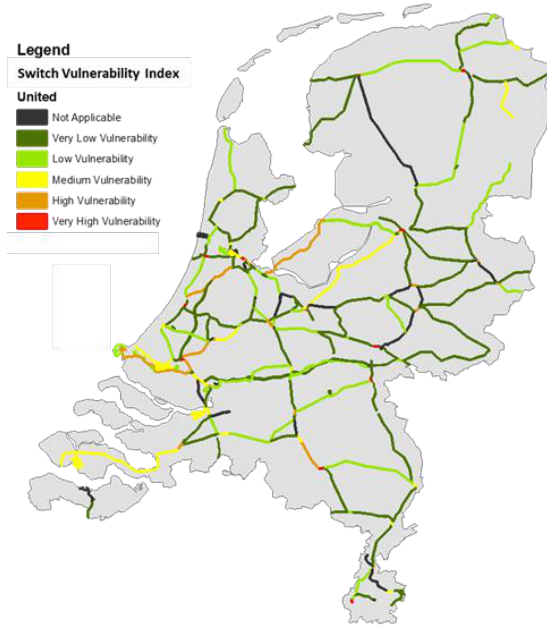
Figure 5 Switch failure probability